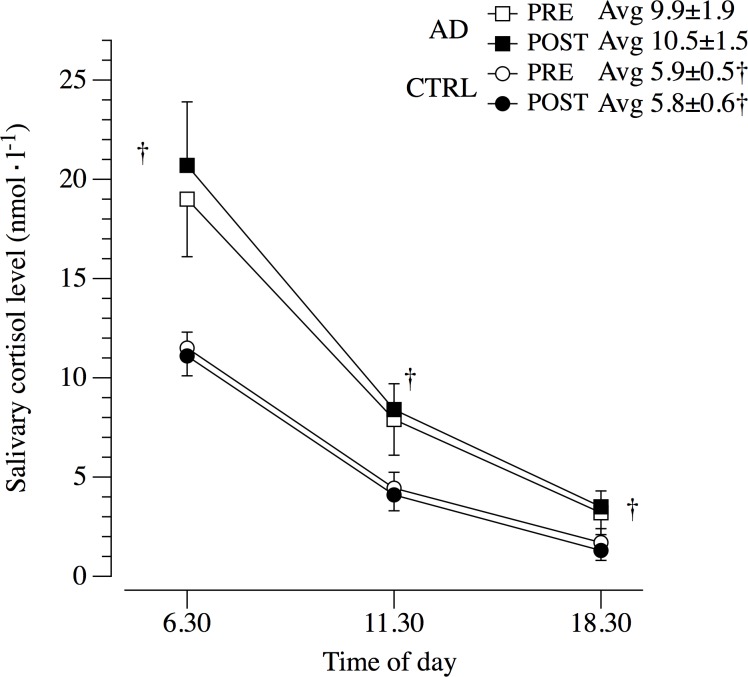
Circadian secretion of salivary cortisol.AD, Patients with Alzheimer’s disease; CTRL, aged matched controls; Avg, daily averaged cortisol. †P<0.05 vs CTRL.